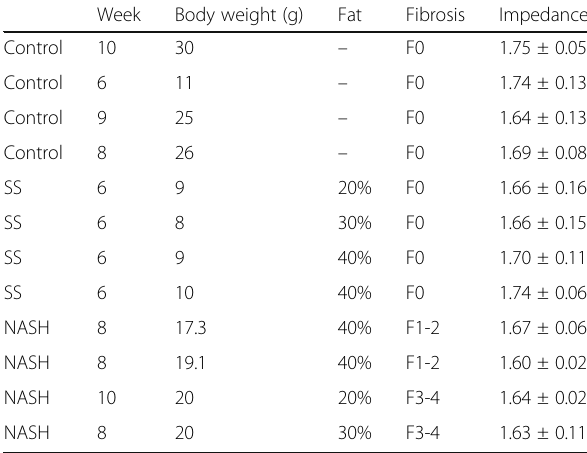
Table 2 Characteristics in mouse